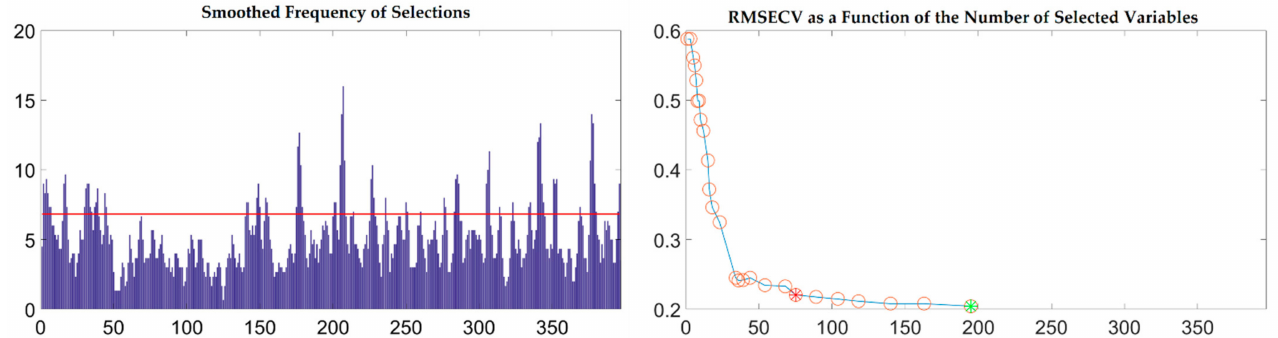
Figure 9. The process of selecting useful wavelengths by using the